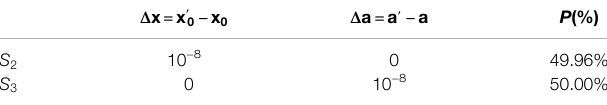
TABLE 3 | The bit change rate of random number sequence S 2 and. S 3